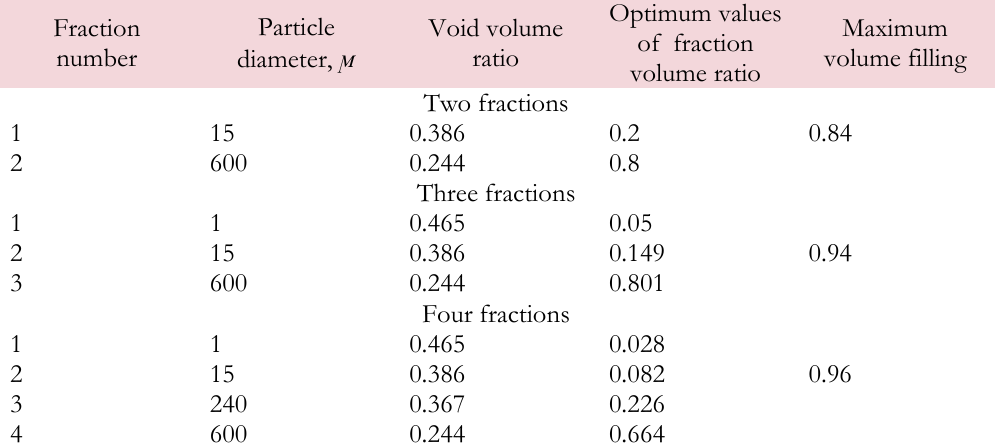
Table 1: Optimum parameter values of silica fraction mixtures.